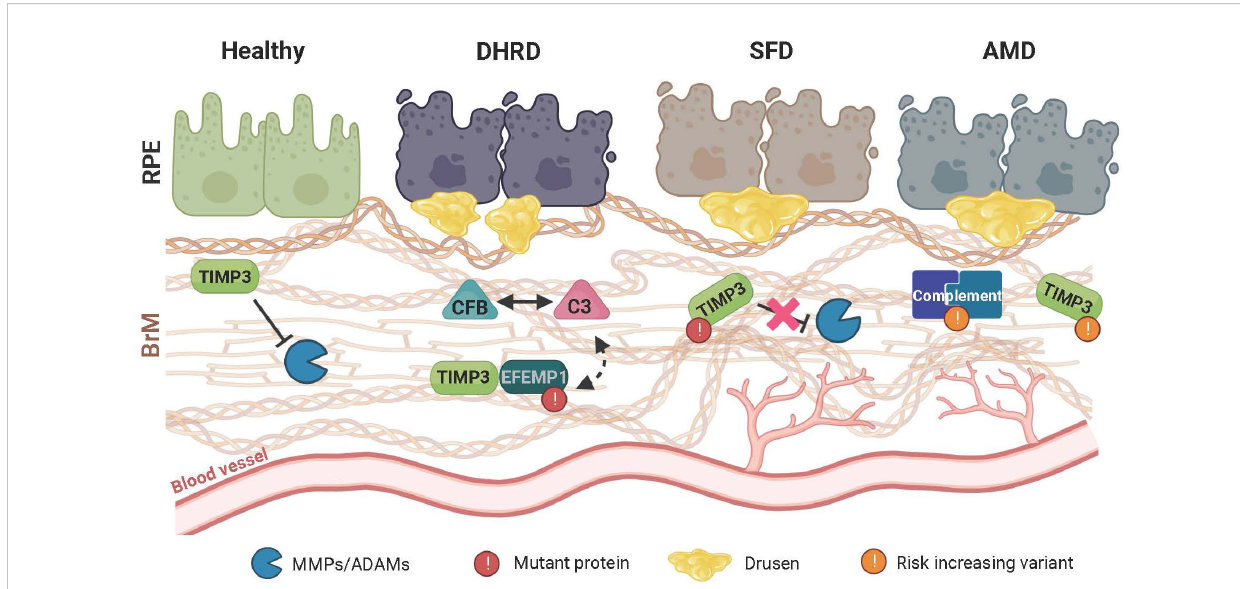
FIGURE 2 Schematic representation of retinal disease pathology on extracellular matrix (ECM) homeostasis and immune regulation. In the healthy retina, a fi nely tuned balance maintains the structural integrity of the extracellular Bruch ’ s membrane (BrM) to prevent in fl ammation and sustain a bene fi cial cellular environment for the retinal pigment epithelium (RPE) and the underlying choroidal blood vessels. Remodeling of BrM by MMPs and their regulation through TIMP3 plays an important role in maintaining this homeostasis. In Doyne honeycomb retinal dystrophy (DHRD), which is caused by a single mutation in the epidermal growth factor-containing fi bulin-like extracellular matrix protein 1 ( EFEMP1 ) gene, an interplay between ECM remodeling and an aberrant activation of the complement system e.g., due to a concomitant increased protein expression of complement component 3 (C3) and complement factor B (CFB), leads to structural changes in BrM and formation of drusen-like deposits, ultimately resulting in RPE atrophy. In Sorsby fundus dystrophy (SFD), which is caused by mutations in the TIMP metallopeptidase inhibitor3 ( TIMP3 ) gene, ECM remodeling and BrM homeostasis is altered leading to RPE atrophy. Subsequently, drusen deposition ensues, which is often accompanied by formation and invasion of new blood vessels towards the RPE. While pathological changes in DHRD and SDF are caused by mutations in single genes, age-related macular degeneration (AMD) is a common disease involving many genetic risk variants with a complex interplay of risk increasing alleles in several components of the complement cascade as well as ECM remodeling enzymes such as TIMP3. Of note, pathological changes seen in AMD closely resemble those seen in